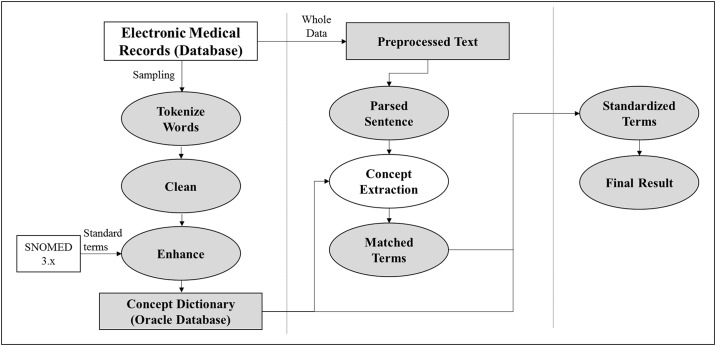
Process diagram of a Concept Extraction-based Text Analysis System.